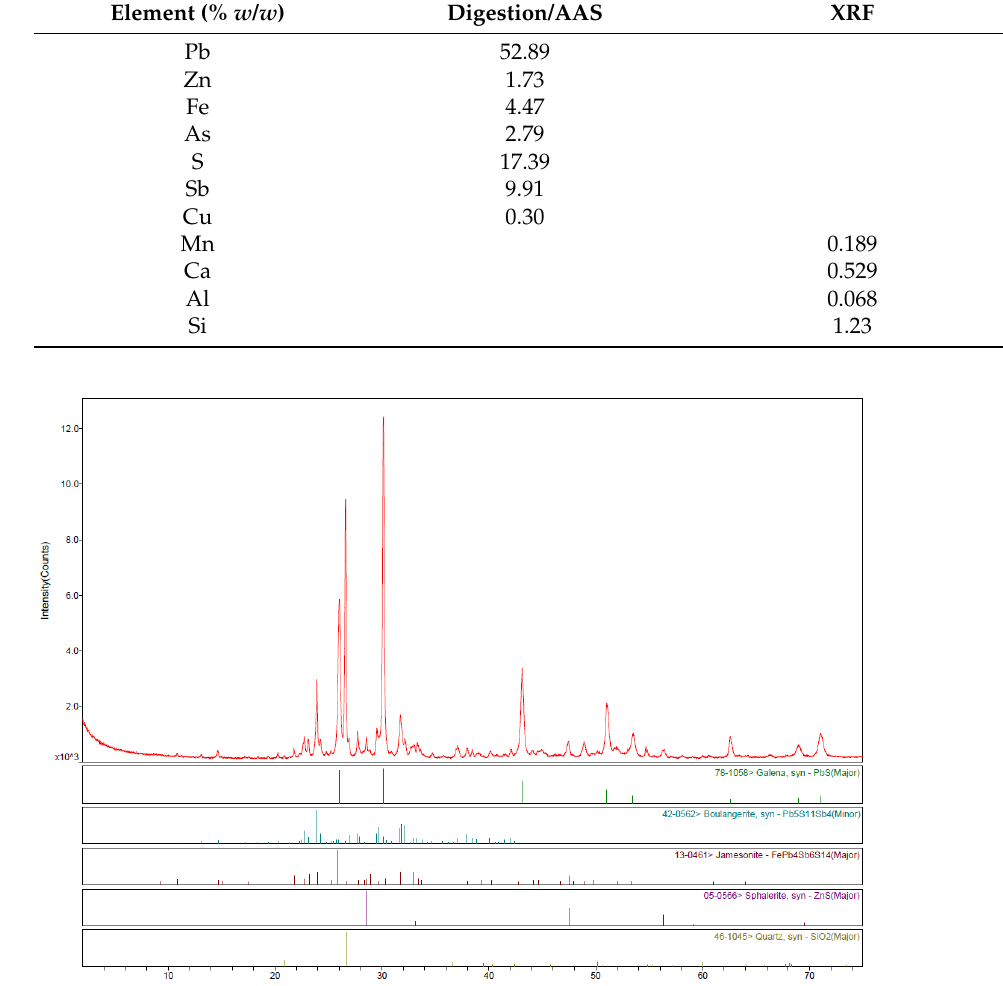
Table 1. Chemical analysis of the representative galena sample.